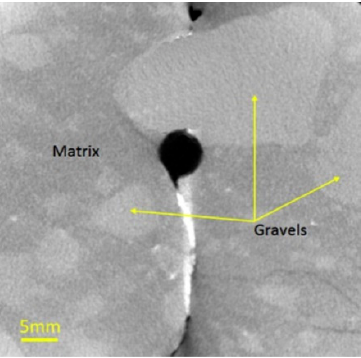
Figure 3. CT image slices of sandstone and glutenite core (Reproduced with permission from [11], Liu et al., Journal of Natural Gas Science and Engineering, Elsevier, 2016)